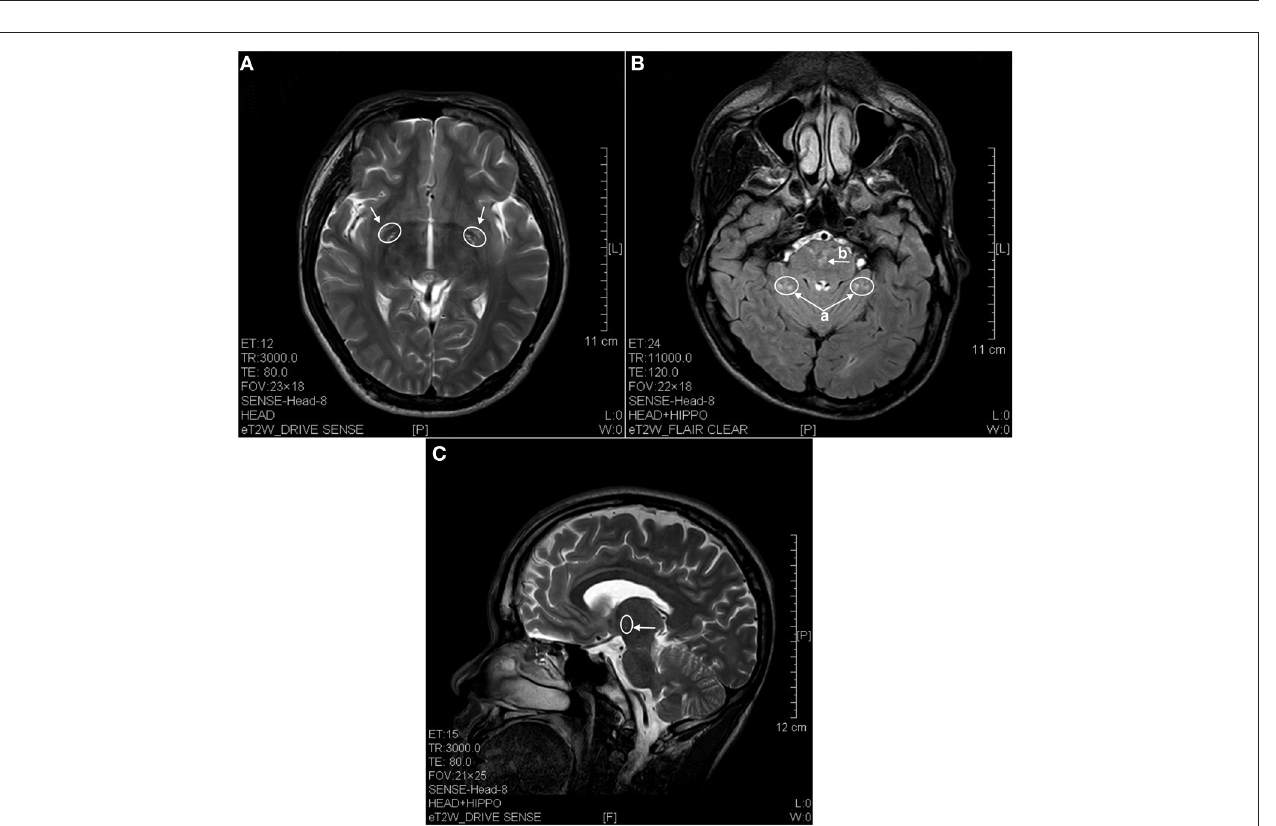
FIGURE 2 | MRI images of the brains of a 4 years ketamine addicts. (A) T2 image of a horizontal brain section showing degenerative hyperintense spots in basal forebrain (arrow). (B) T2 image of a